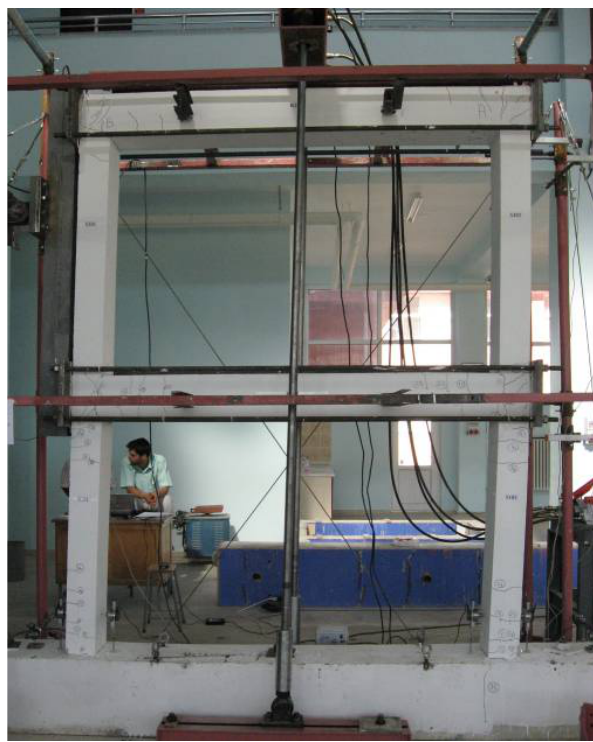
Fig. 4. Reference bare frame RFB1.